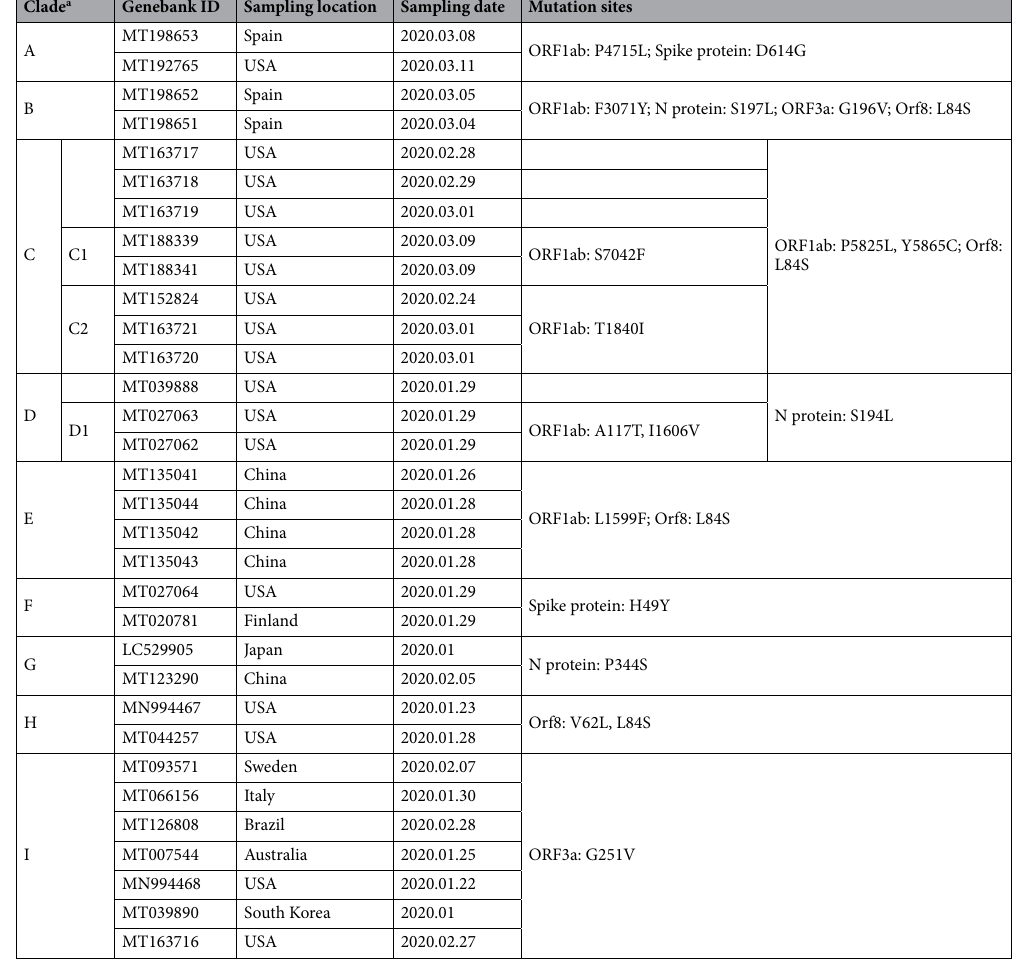
Table 1. Common mutations sites of the sub-clades in the SARS-CoV-2 phylogenetic supertree. a The clades are coded as in Fig.